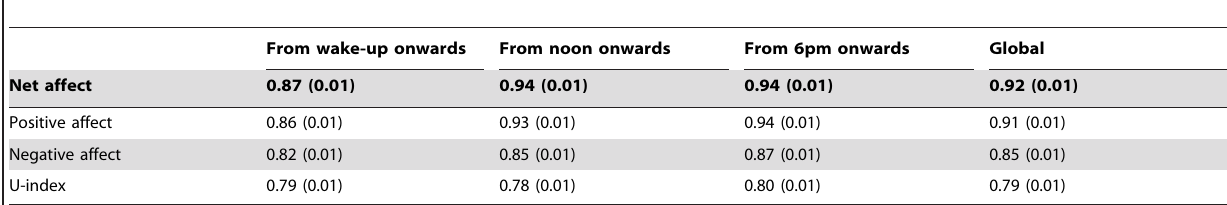
Table 3. AUC values (s.e.) corresponding to ROC analyses comparing the morning, afternoon, and evening portions of the second evaluation with the full day in the same evaluation.